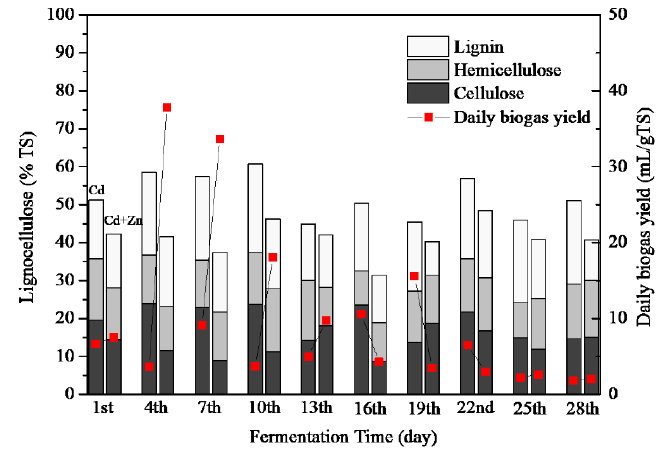
Figure 6. Impact of Cd and Cd + Zn addition on lignocellulose contents during the fermentation.